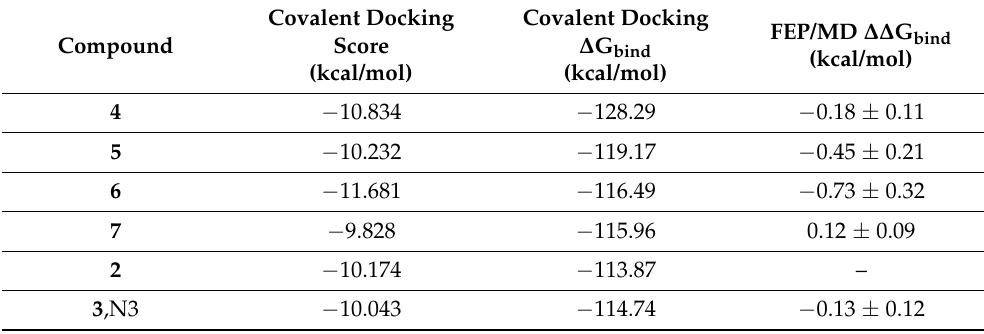
Table 2. Computational scores (covalent docking score and ∆ G bind derived from docking studies, and ∆∆ G bind derived by FEP calculation ) obtained for compounds 4 – 7 compared to the reference compounds 2 and 3